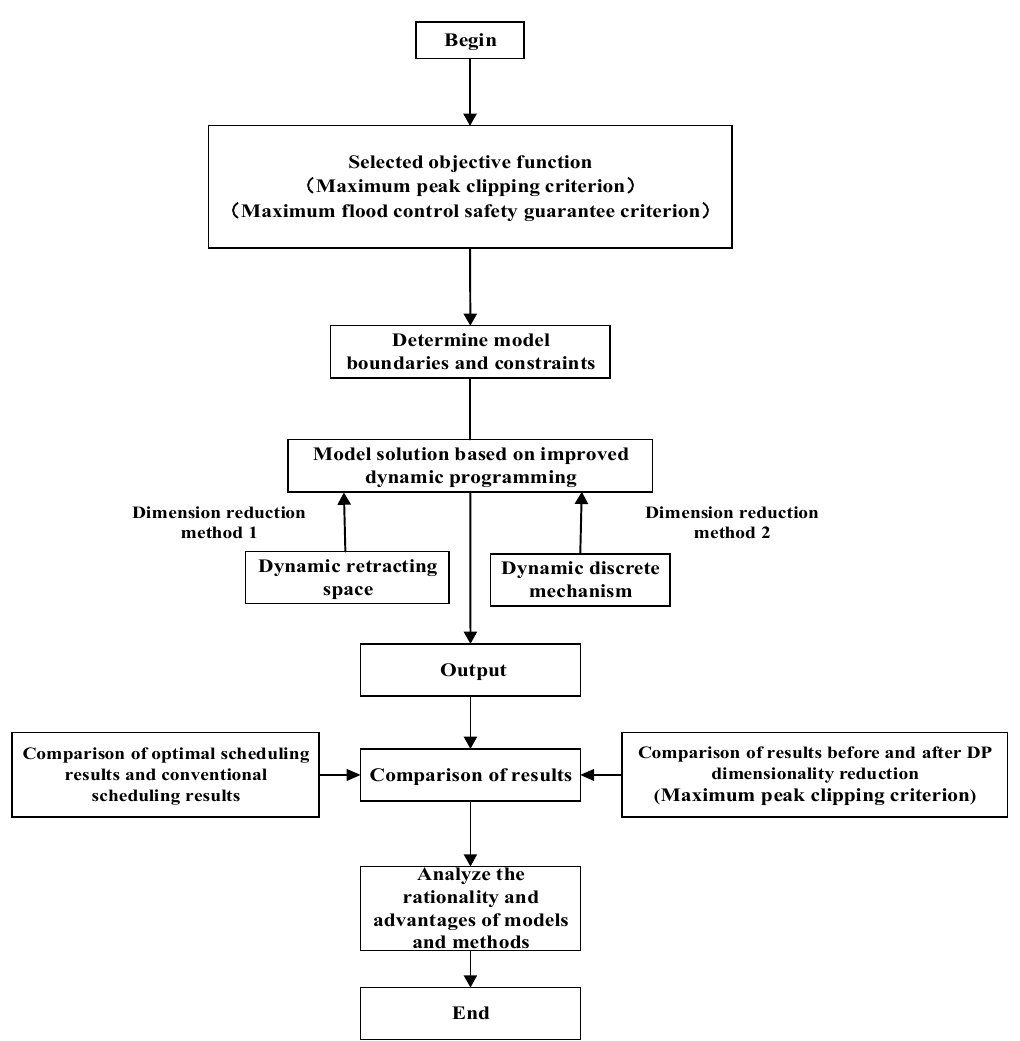
Figure 5. Implementation scheme diagram of improved DP algorithm.